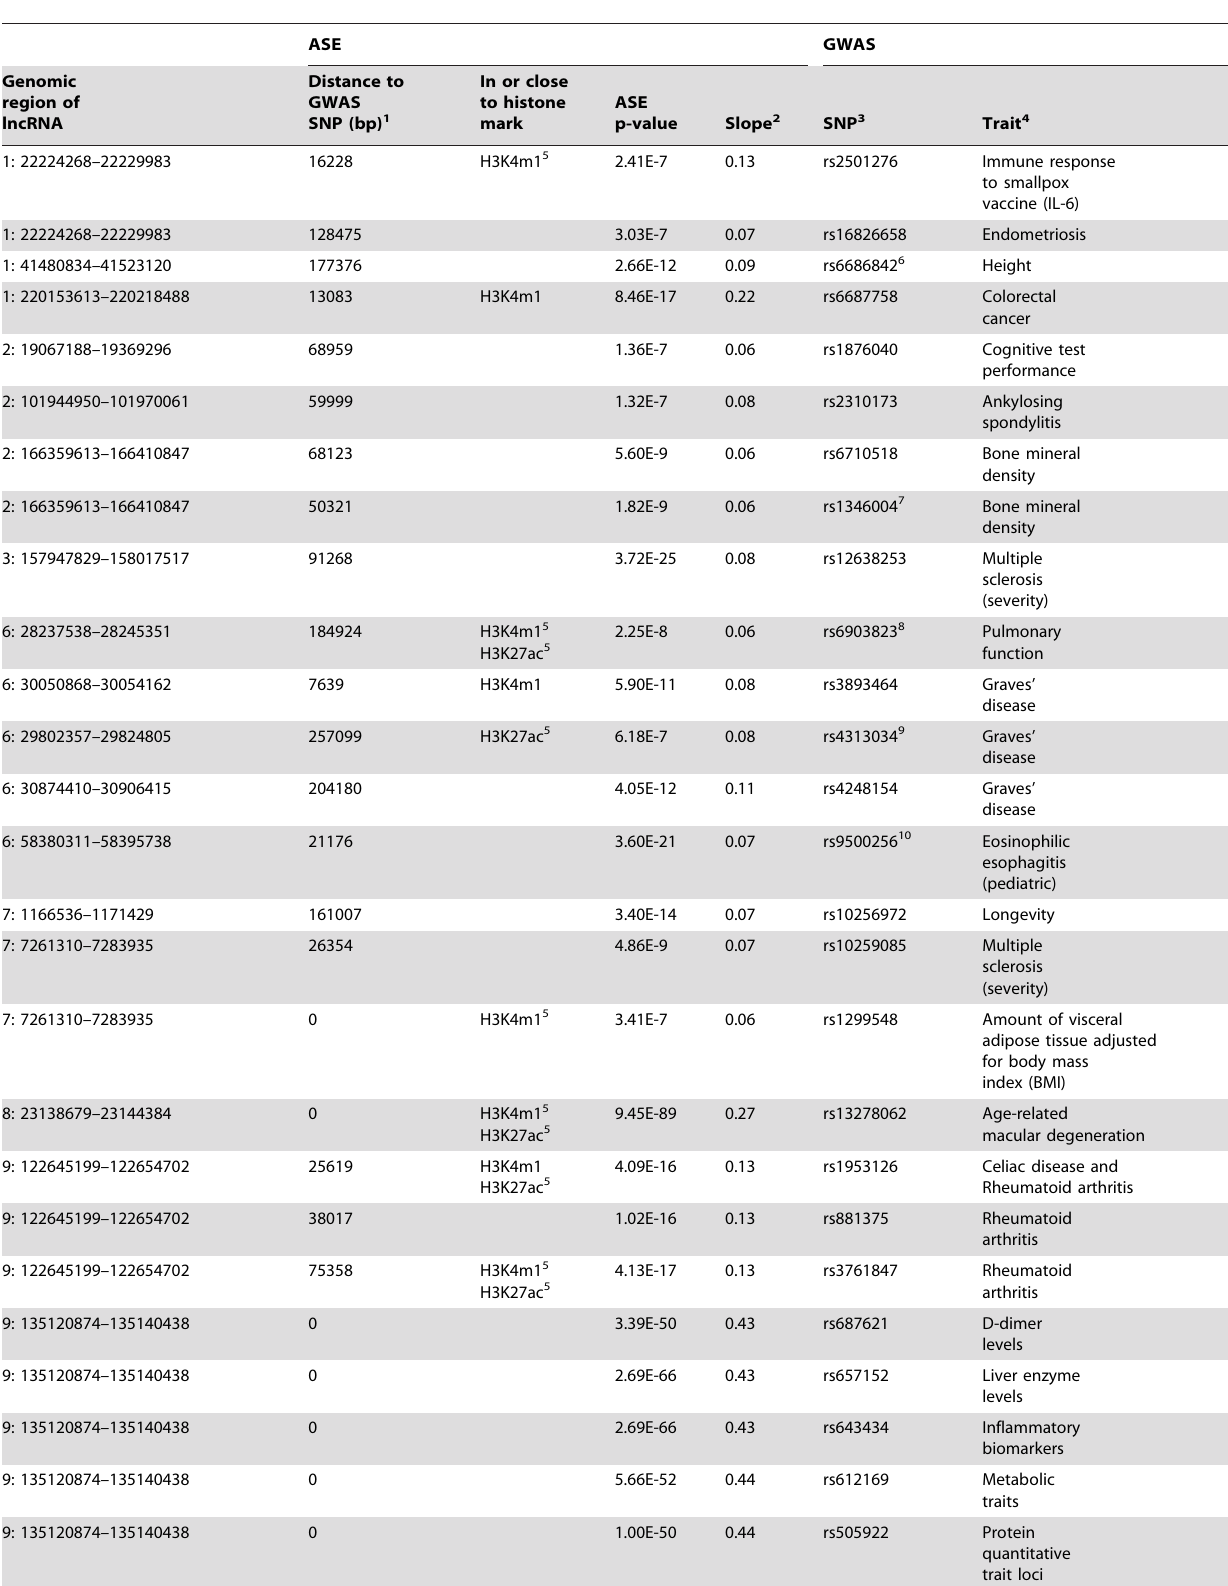
Table 2. SNPs associated with allele-specific expression of lncRNA windows with published trait- or disease-associations from genome-wide association